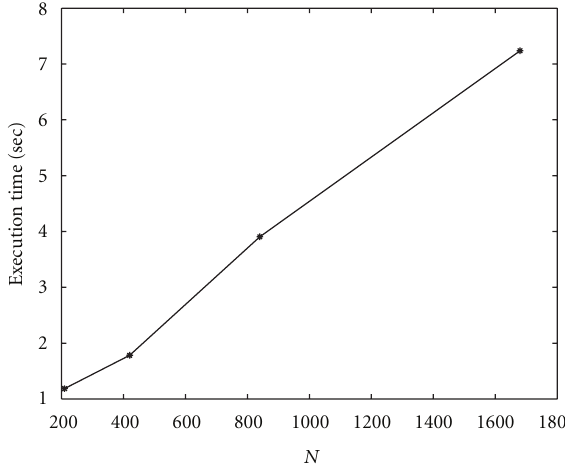
Figure 30: Scalability of parallel Algorithm I, as N and p vary. Each point of the graph refers to the execution time of the parallel implicit algorithm at ( p = k · p 1 , N = k · N 1 ), where p 1 = 1, N 1 = 210 and k = 1,2,3,4. Δ τ I = 0 .